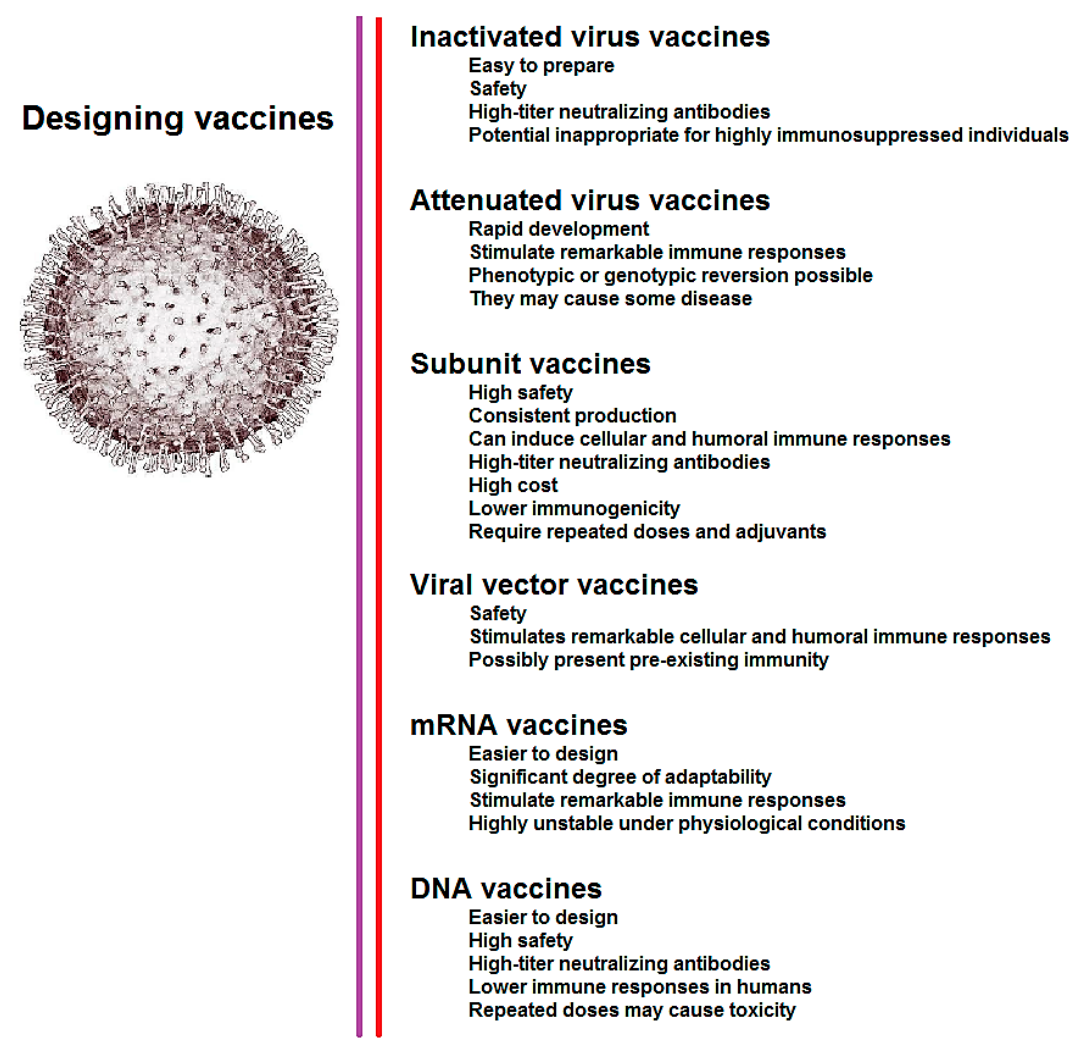
Figure 15. Some important vaccine strategies and their attributes based on the data from Refs. [103,104,107,108]. Table 2. Some important vaccine candidates for COVID-19.